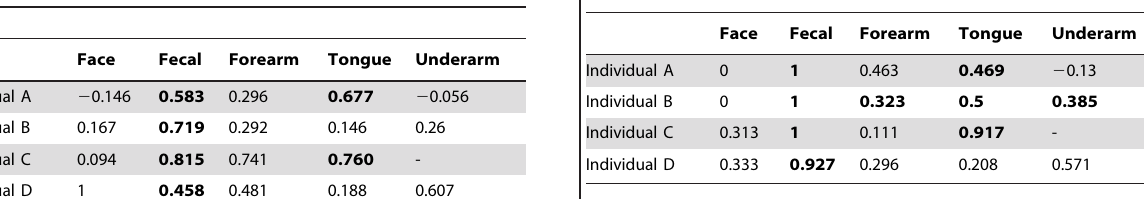
Direct PCR of the Human